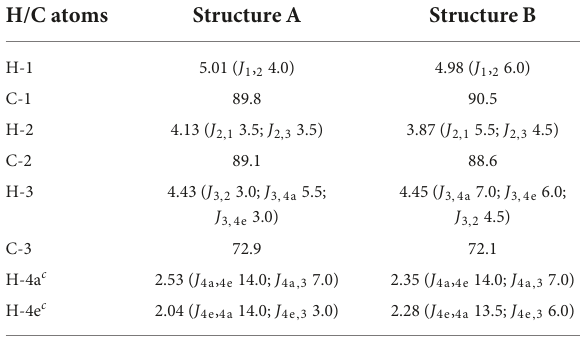
TABLE 3 1 H and 13 C chemical shifts a and coupling constants b of saturated cyclic structures A and B ( Figure 9 ), generated by the incubation of M-block, G-block, and M. pyrifera alginates with AlyRm4, recorded in D 2 O at